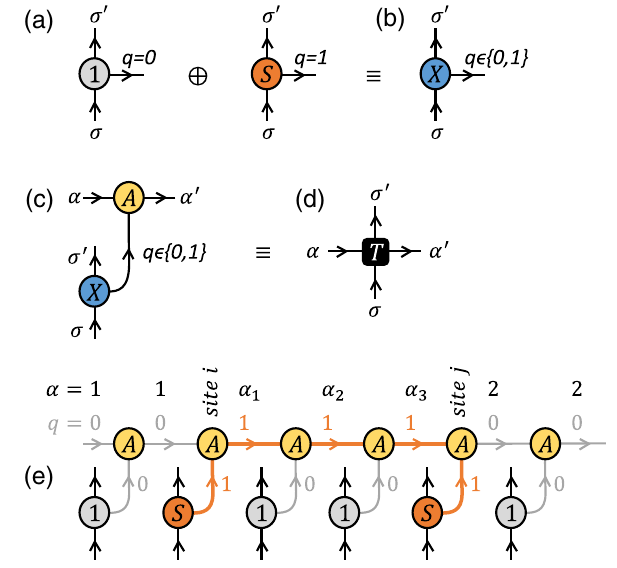
FIG. 14. (a) The local identity and spin operator for the SU(2) spin-symmetric Heisenberg model, which transform according to S ≡ q ¼ 0 and q ¼ 1 , respectively. All relevant local operators, including the identity operator, can be combined into the rank-3 tensor X [(b)]. (c) The super-MPS described by the rank-3 tensor A can be contracted with the operator index in X to form the rank- 4 local tensor T in the SU(2)-invariant MPO [(d)]. (e) Typical sequence that occurs in the construction of the MPO via the super-MPS that describes a specific individual interaction term ˆ S ˆ S † i · j . This demonstrates how the quantum number of the IROP S simply stretches like a string (red line) along the virtual bonds in between the two sites i and j where the spin operators act. The values α 1 ; α 2 ; … on given A -tensors are reserved for this very specific interaction term, where, in general, the indices α i > 2 are not all the same. Note that the arrows on the red line are reversed with respect to site j , which thus needs to incorporate the Clebsch-Gordan coefficients ð 1 ; 1; 0 Þ that combine the S ¼ 1 multiplet of the spinor S with its dual (also S ¼ 1 ) into a scalar. It is this CGC on the A tensor of site j within the super-MPS that takes properly care of the dagger in the scalar product Similarly, also the coupling strength J is encoded with the A tensor in the